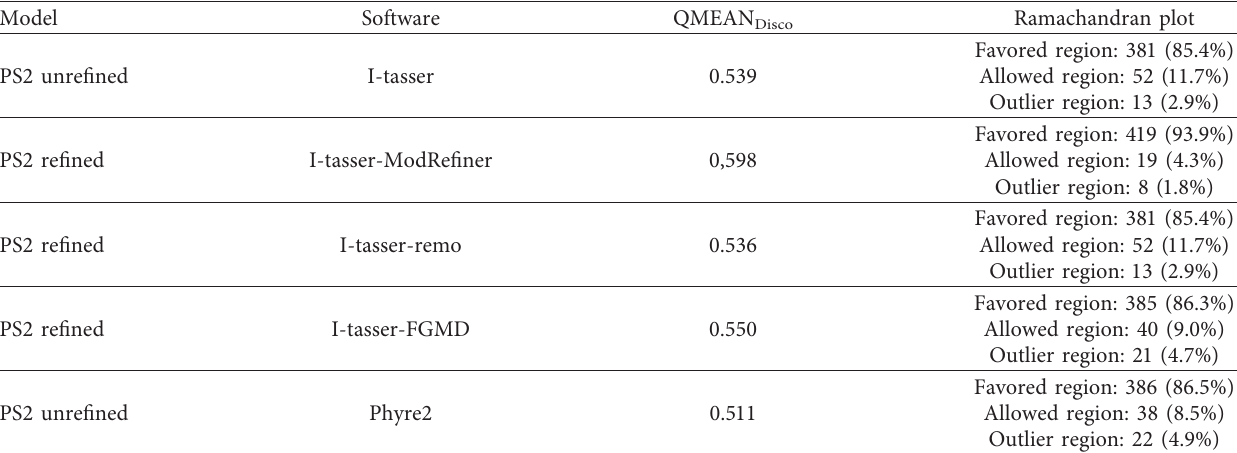
Figure 2: Alignment of the PS1 protein and the hypothetical model of PS2. (a) Alignment of primary sequences in FASTA. (b) Global three- dimensional alignment. Template protein PS1 Subunit B with ID: 6IYC (violet), complete model of protein PS1 with Phyre2 (dark blue), complete model of protein PS2 with I-Tasser and refinement FGMD (cyan), modeled active site of PS2 (red), and active site of PS1 (yellow). Table 1: Energetic and stereochemical validation of the created models of the PS2